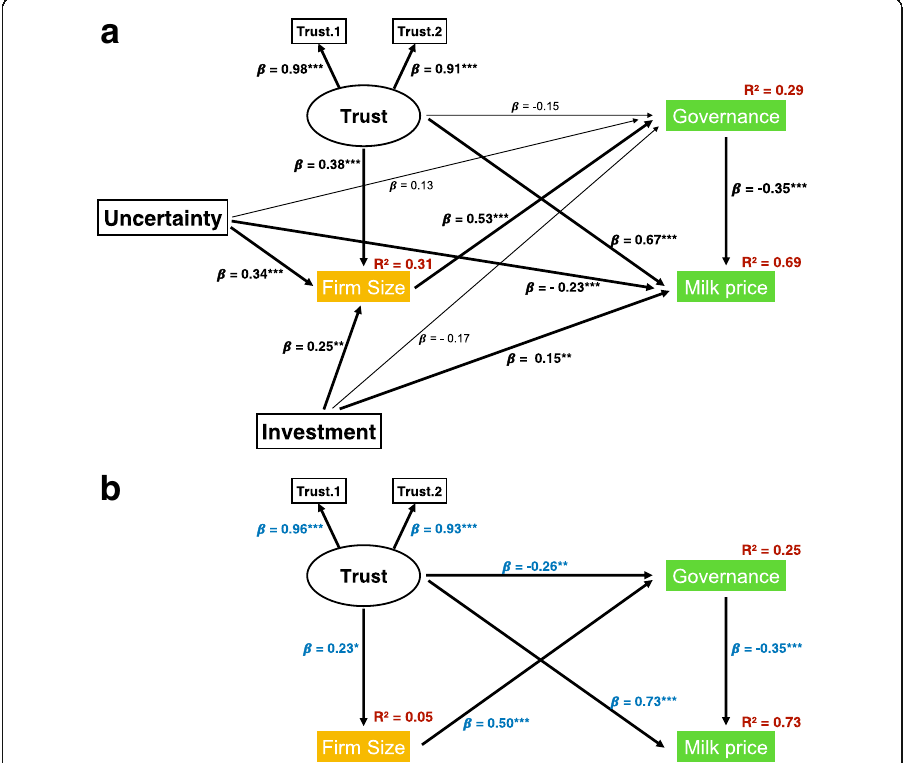
Fig. 3 H3 “ relationship ” SEM ( a ) initial specification ( b )